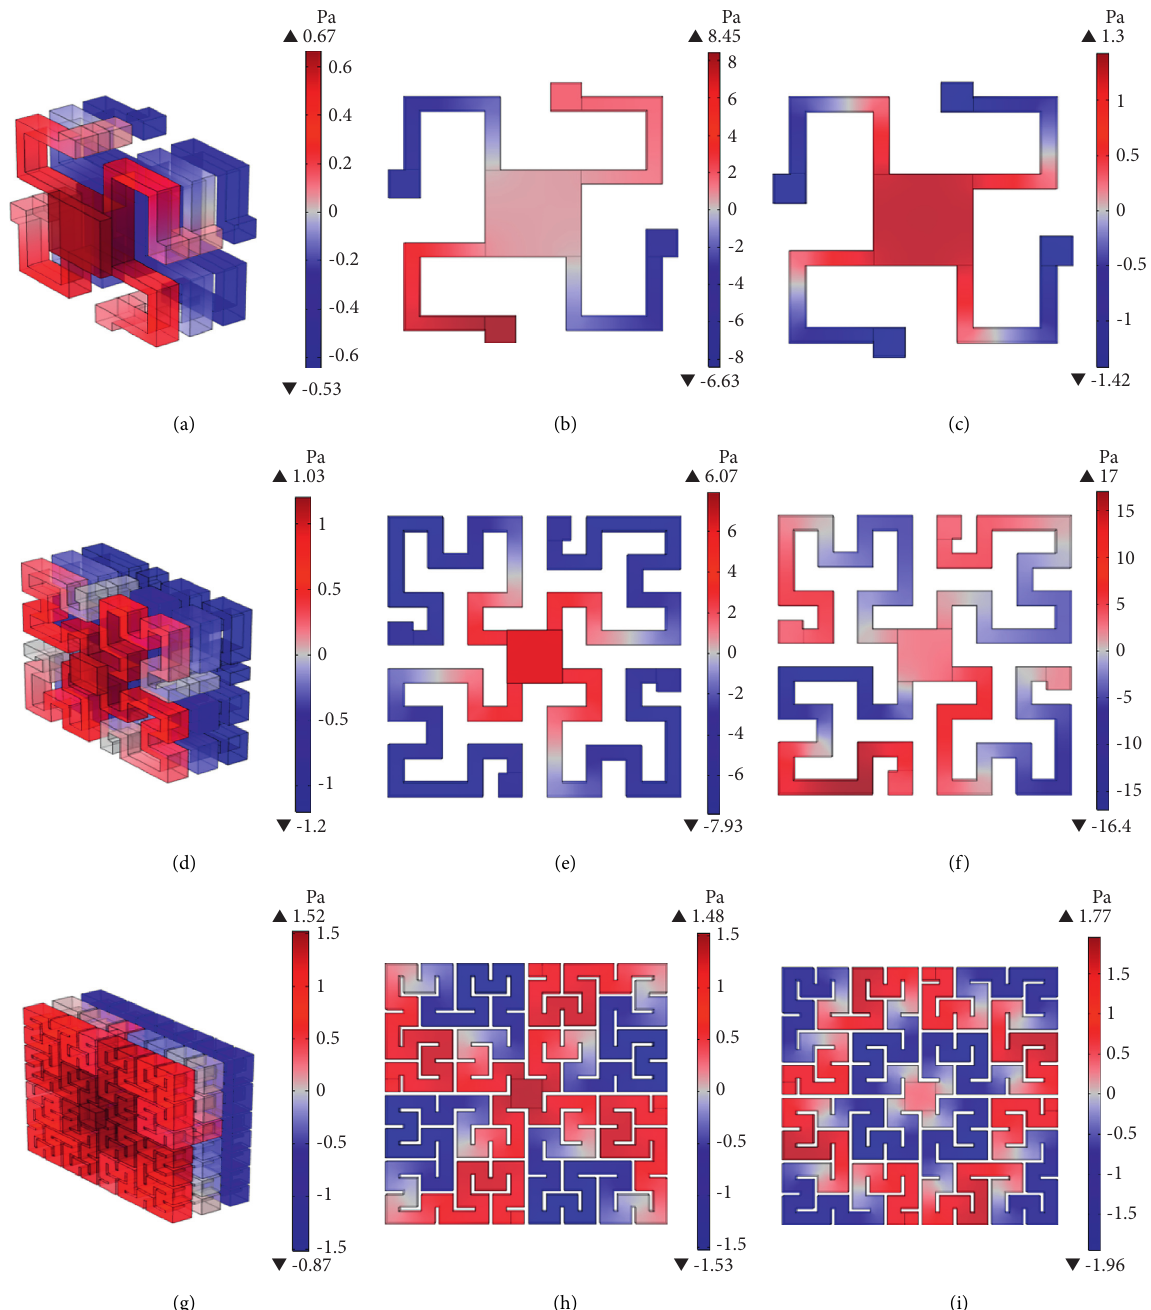
Figure 5: Sound pressure distribution for each order metamaterial structure. (a) 214 Hz overall sound pressure distribution. (b) 725Hz single-layer sound pressure distribution. (c) 1013Hz single-layer sound pressure distribution. (d) 119 Hz overall sound pressure distri- bution. (e) 833Hz single-layer sound pressure distribution. (f) 1569Hz single-layer sound pressure distribution. (g) 69 Hz overall sound pressure distribution. (h) 905Hz single-layer sound pressure distribution. (i) 1576Hz single-layer sound pressure